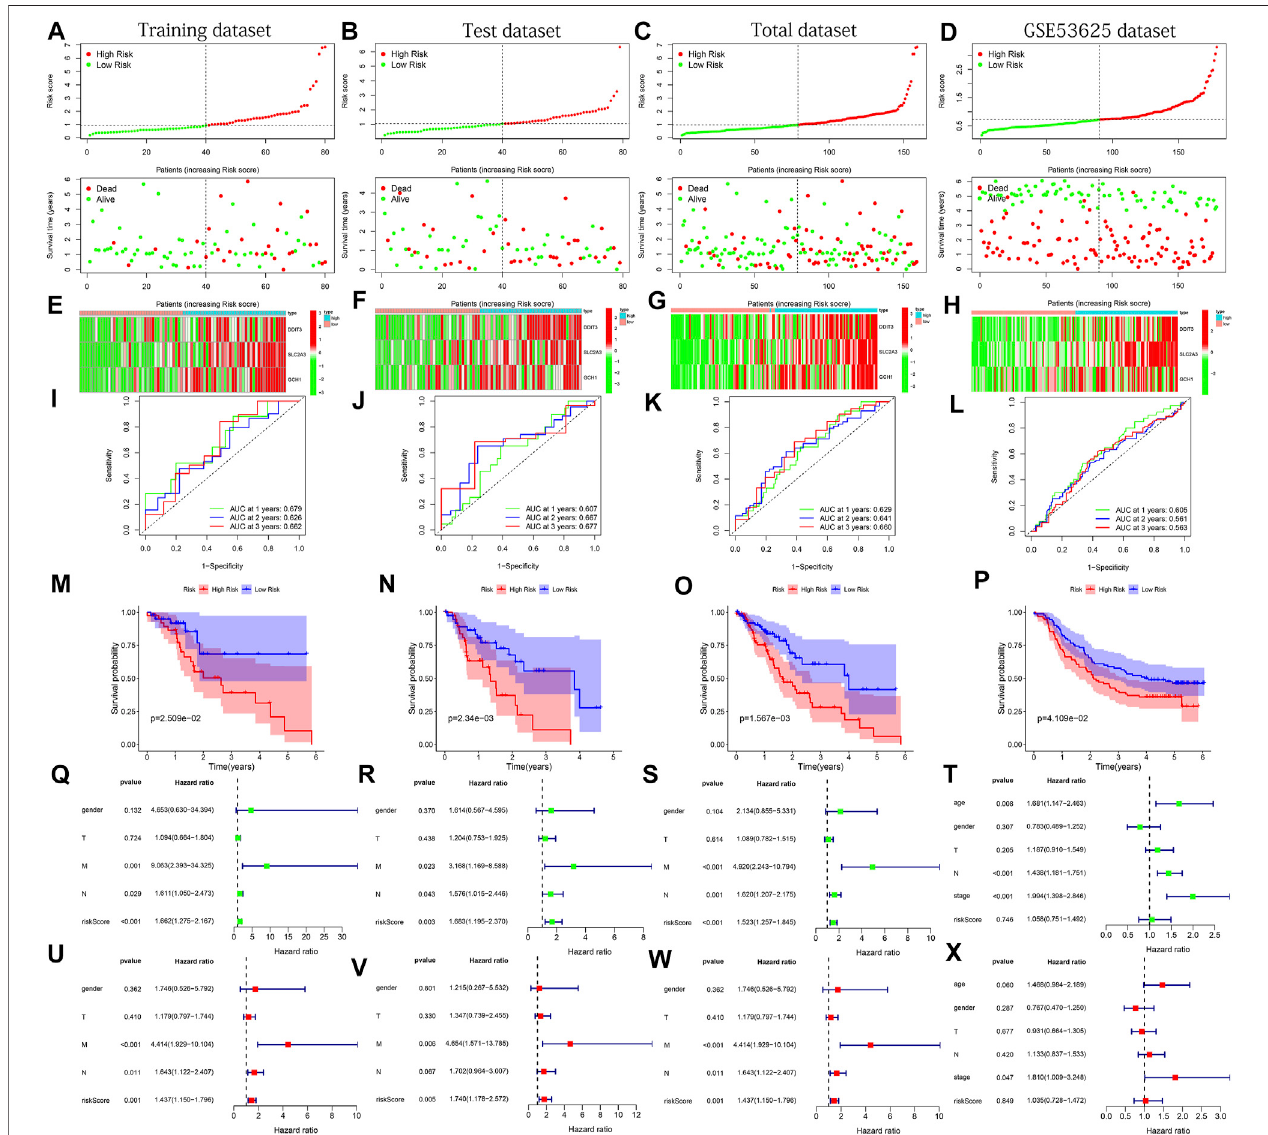
FIGURE3 | The results ofvarious methods toverify the performanceof themodel based on the training, test, total and GSE53625 datasets. (A – D) Risk score and survival time plots. (E – H) Expression heat map of 3 PR-DE-IRFeGs. (I – L) 1-, 2-, and 3-year ROC plot (M – P) Kaplan-Meier survival plot. (Q – T) Forest plots for univariate Cox regression. (U – X) Forest plots for multivariate Cox